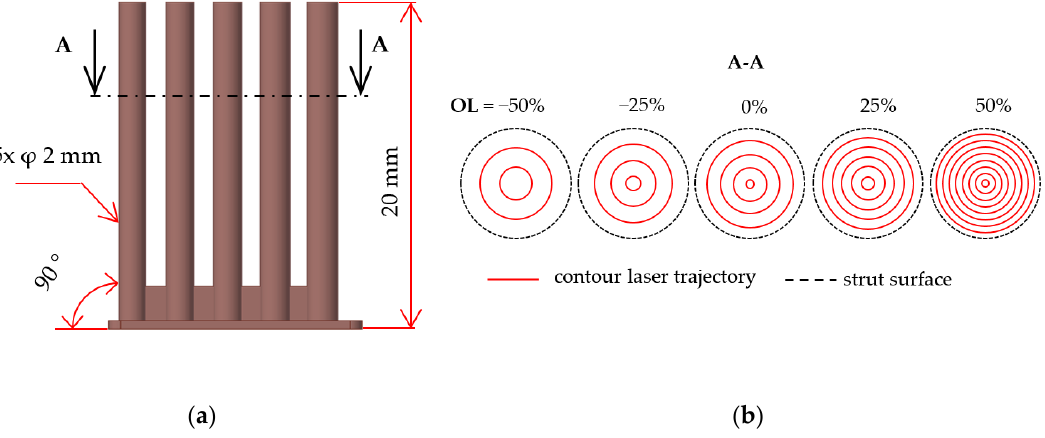
Figure 5. ( a ) Shape of the samples with inclination of 90°; ( b ) contour strategy with different overlap parameter.